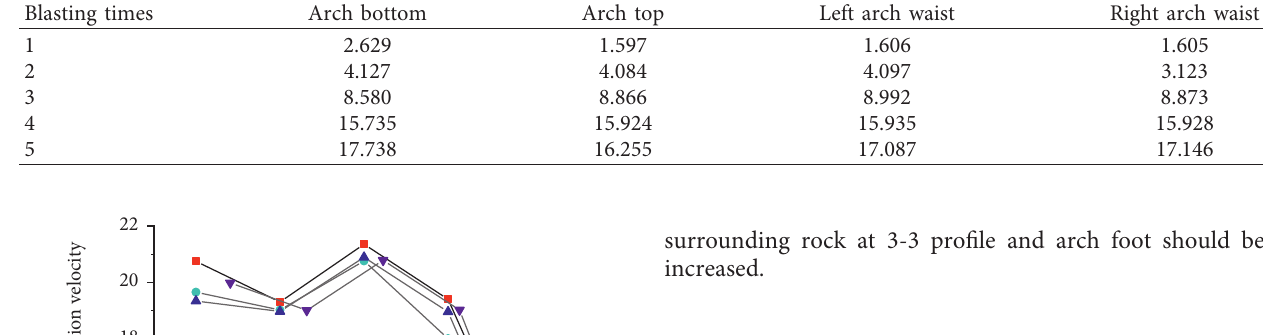
Table 7: Peak value of vibration velocity at each measuring point of profile 5-5 (10 − 2 m/sec). Blasting times Arch bottom Arch top Left arch waist Right arch waist